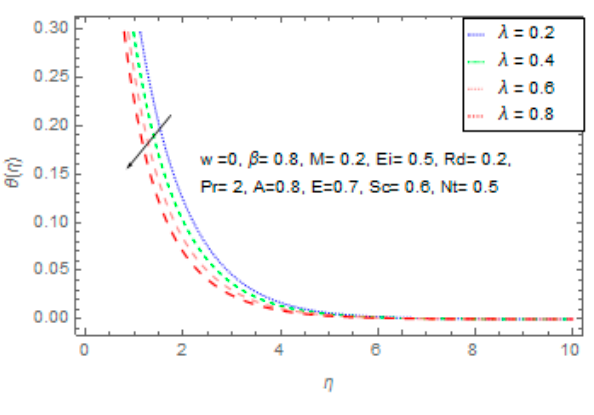
Figure 4. Influence of λ on θ ( η ) .